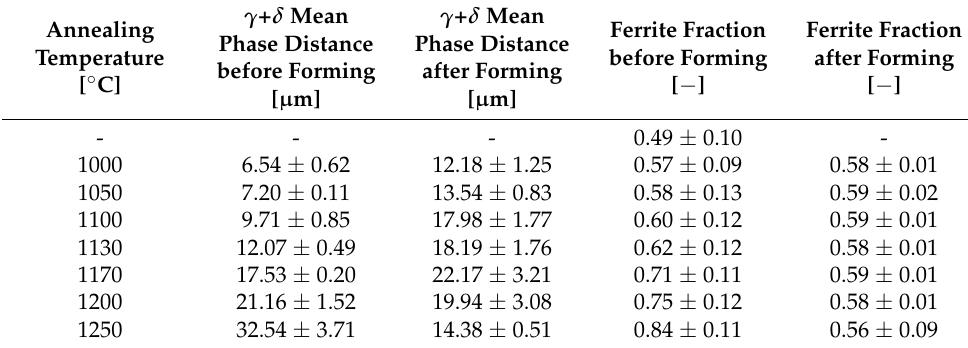
Table 2. Microstructure parameters of the duplex material after solution annealing of 1 h at different temperatures and after forming at 1100 ◦ C and 1 s − 1 measured from optical microscopy.